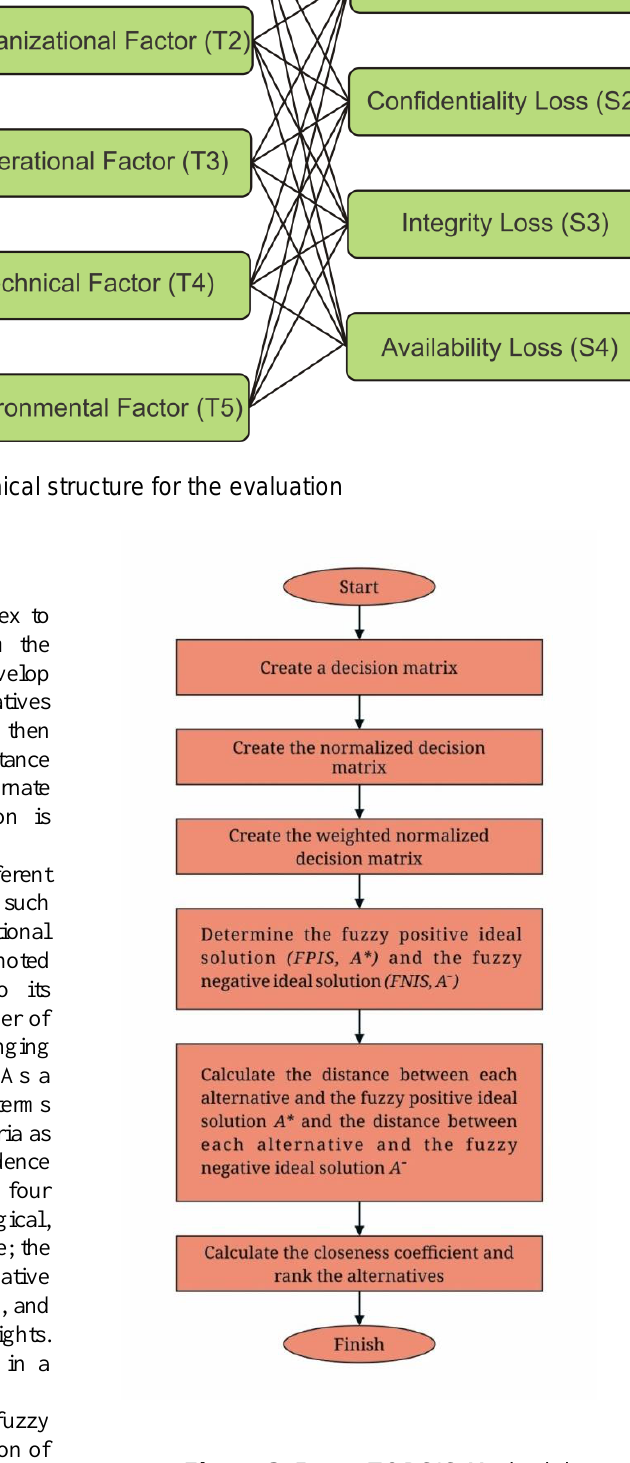
Figure 3. Fuzzy TOPSIS